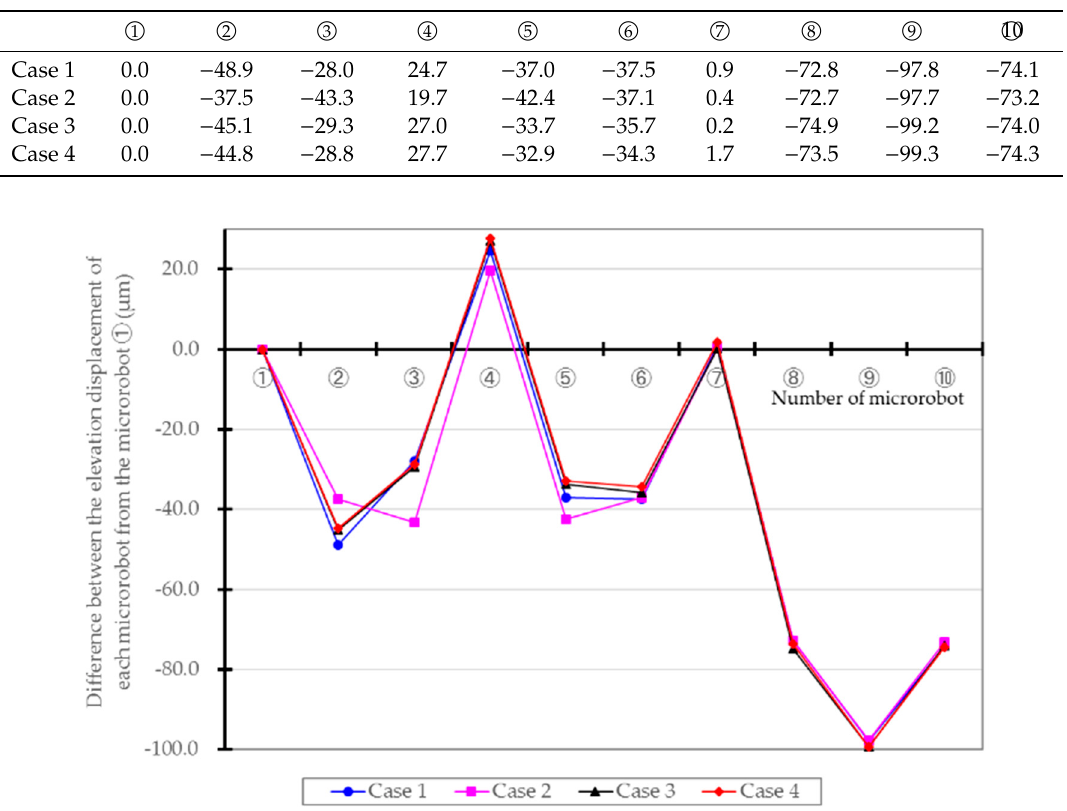
Figure 14. Difference between the elevation displacement of each microrobot from the parent microrobot ① . The other microrobots are being pulled up by microrobots ① , ④, and ⑦ , which are the driving microrobots. The gaps between microrobots ⑦ and ⑧ and between microrobots ⑩ and ① were the largest, and the maximum was approximately 75 μ m.